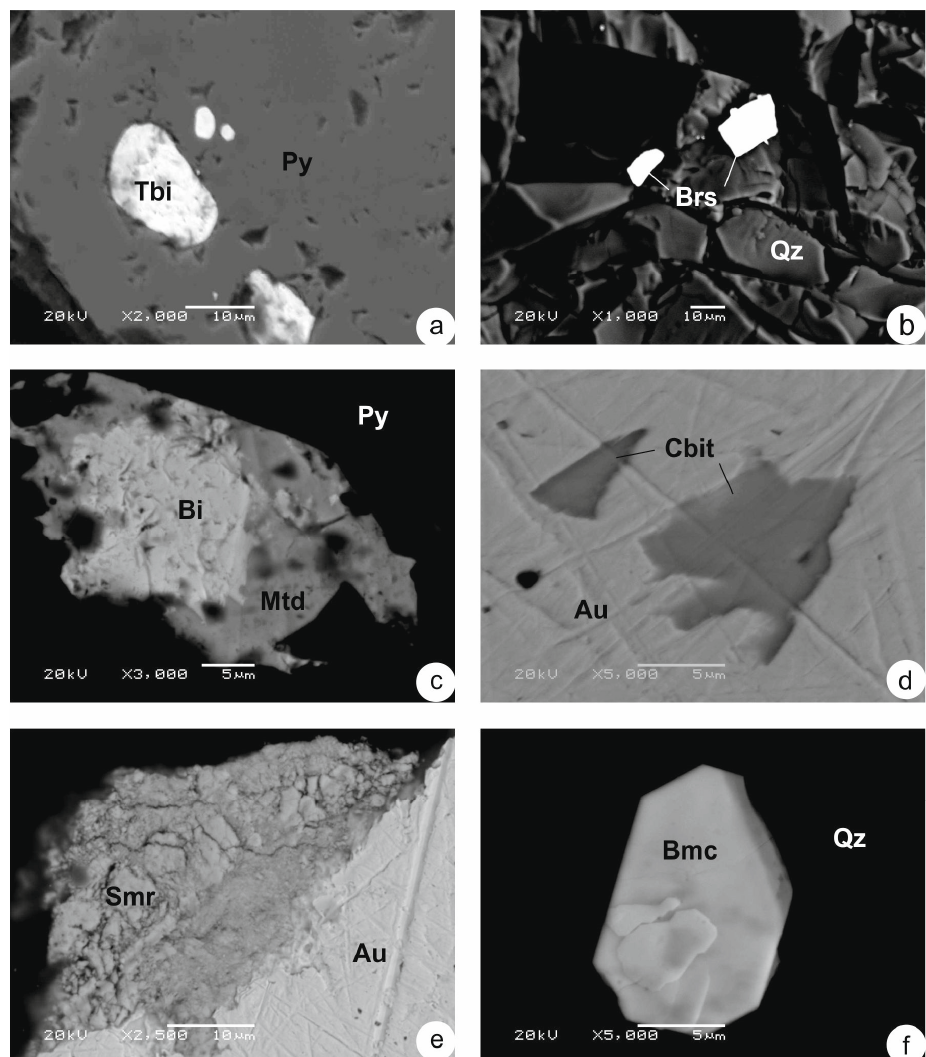
Figure 3. Gold–bismuth mineralization of the Spokoininsky ore cluster: ( a )—ellipsoidal grains of